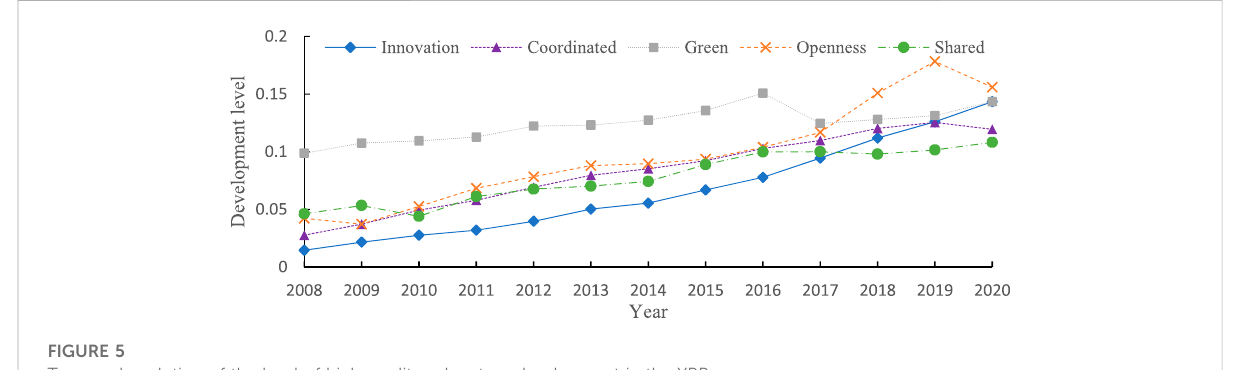
FIGURE 5 Temporal evolution of the level of high-quality subsystem development in the